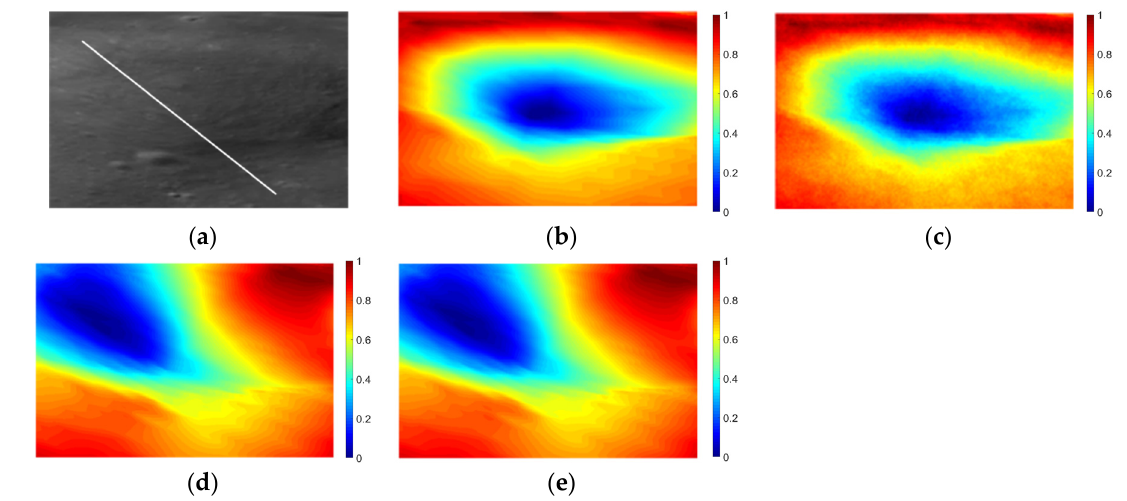
Figure 9. ROI 2 and reconstruction results of the three methods ( a ) Enlarged view of region 2, ( b ) ground truth ( c ) PPS result, ( d ) PSPP result, ( e ) PSOP result.